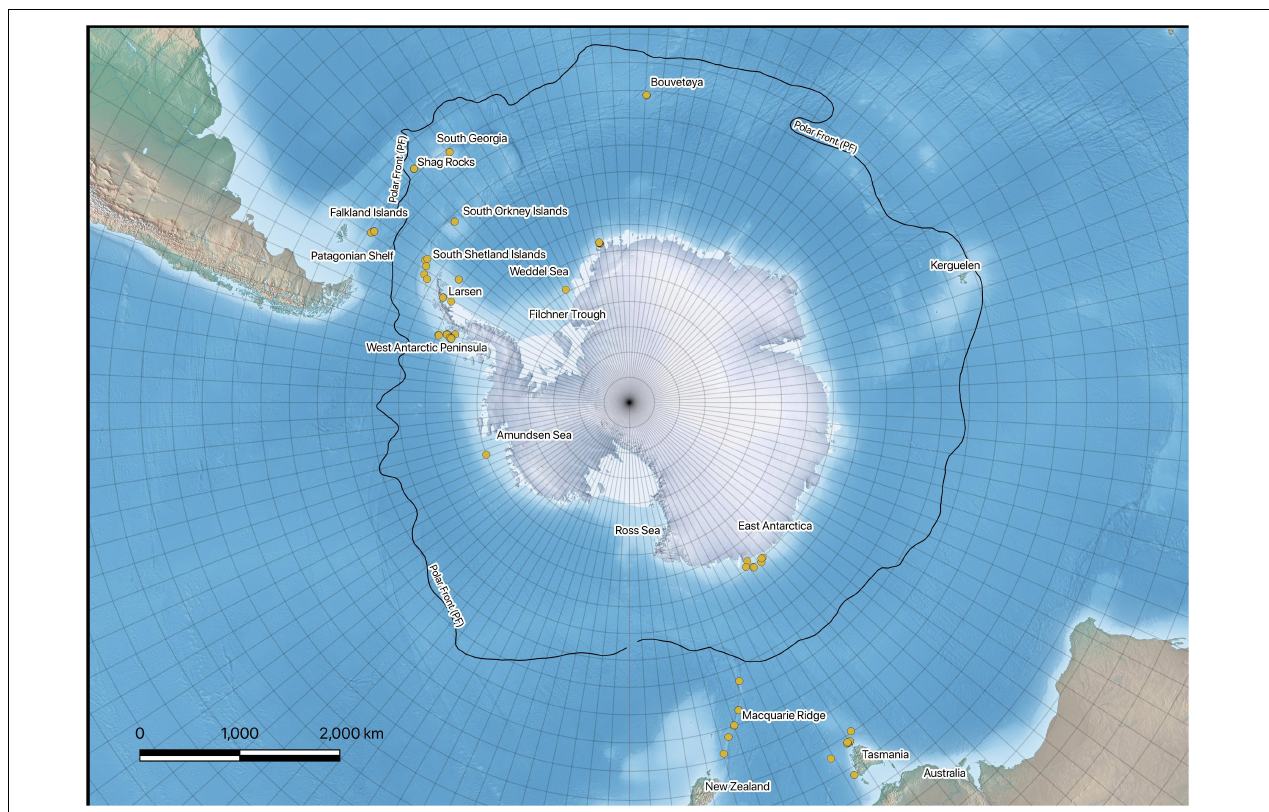
FIGURE 1 | Map of the Southern Ocean showing the regions sampled over several